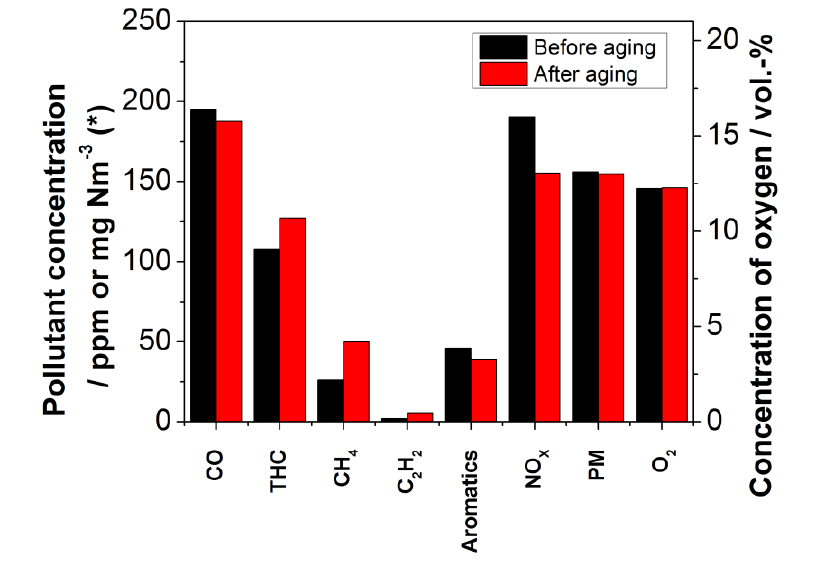
Figure 10. Comparison of the concentrations of selected pollutants and oxygen in the exhaust stream after the catalyst in the fresh state (black bars) and after 16 h of use (red bars); * The measurement unit of the particulate matter concentration is mg Nm −3 and for all other pollutants